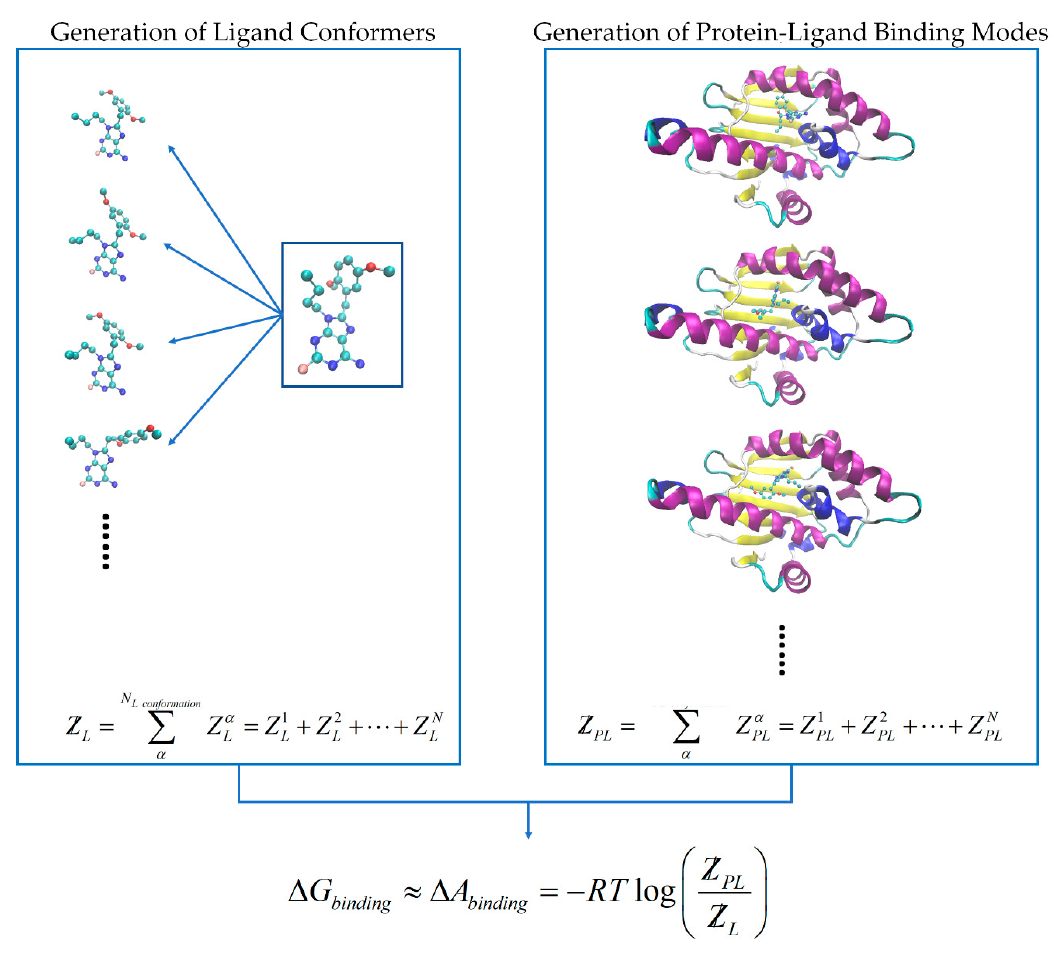
Figure 11. A flow chart for the ensemble energy calculation protocol employed in this work. Both bound-state and free-state ensembles were generated using the programs indicated (Heatmap docking and MT-CS). The final free energy change was then calculated using the ratio of partition functions Z / Z PL L